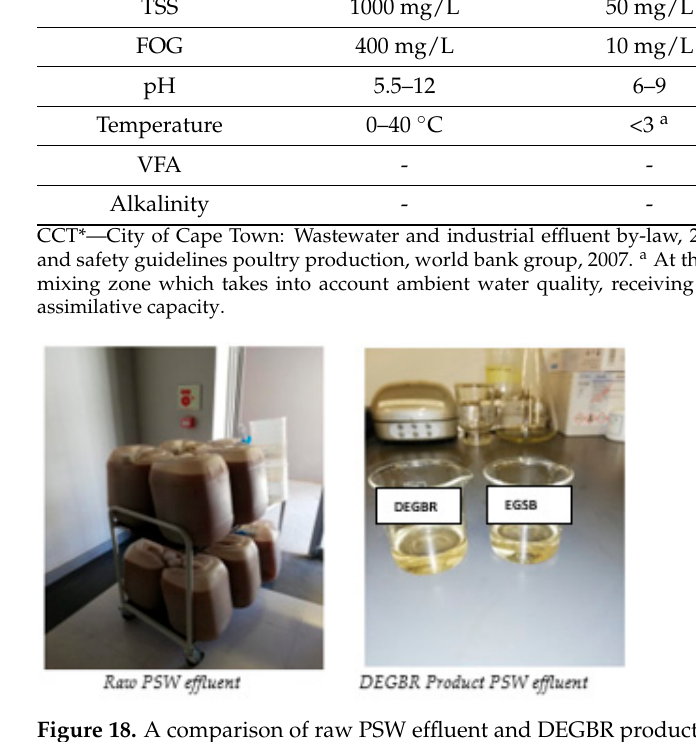
Figure 18. A comparison of raw PSW effluent and DEGBR product sample.